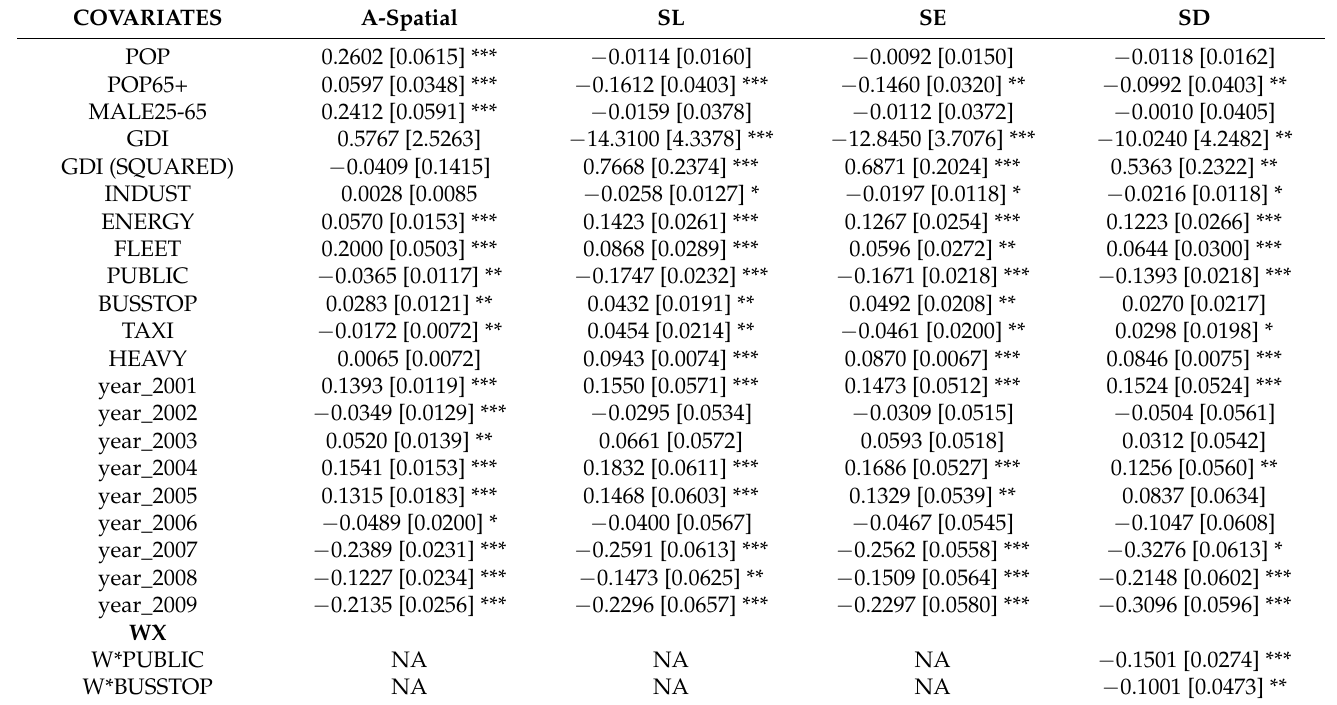
Table 7. Estimates of total impacts: a-spatial model and spatial-PD-STIRPAT models.